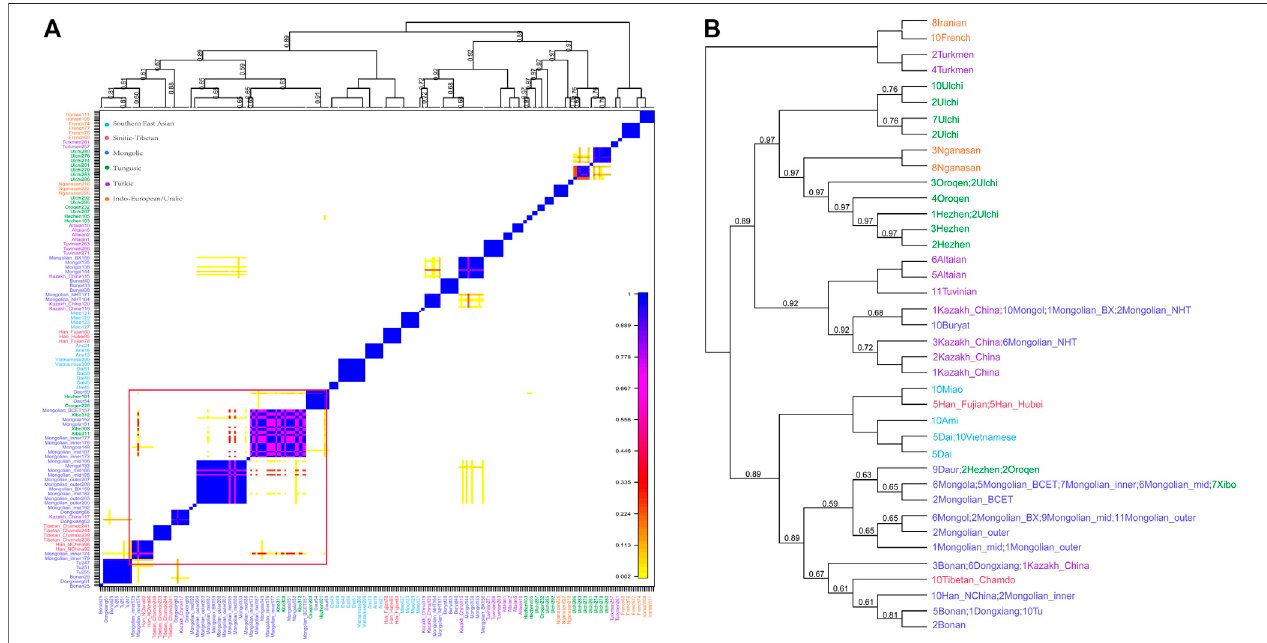
FIGURE 3 | Pheatmap of sharing haplotypes and clustering dendrogram and by FineSTRUCTURE based on the chunk length.